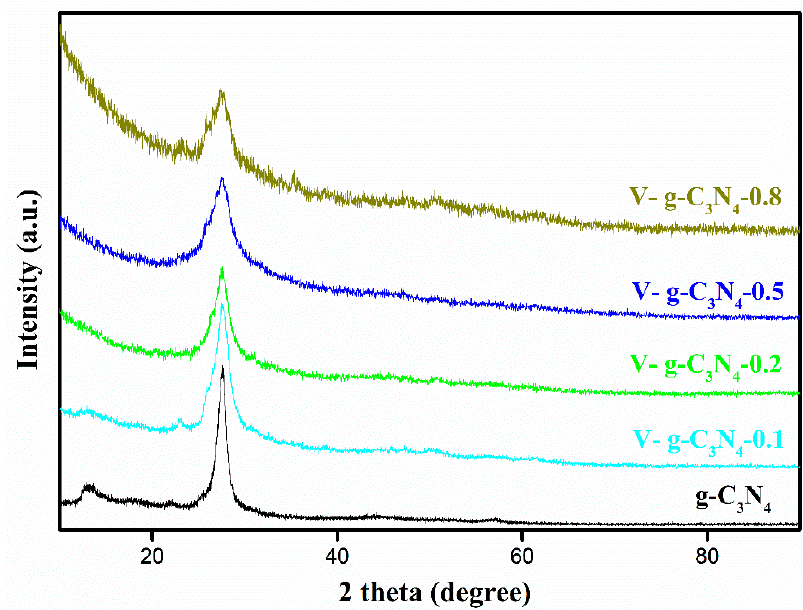
Figure 2. XRD patterns of the materials.